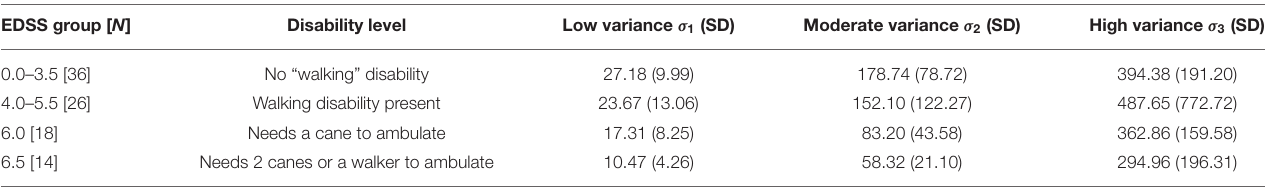
TABLE 3B | Variance of physical activity level distribution per disability (EDSS) group (distribution of σ ).